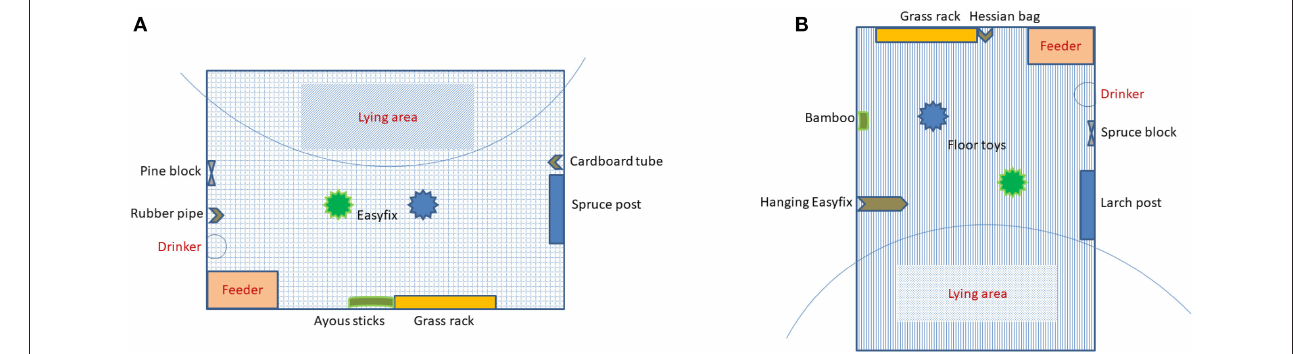
FIGURE 1 | Enrichment layout in the (A) weaner pen and (B) finisher pen.